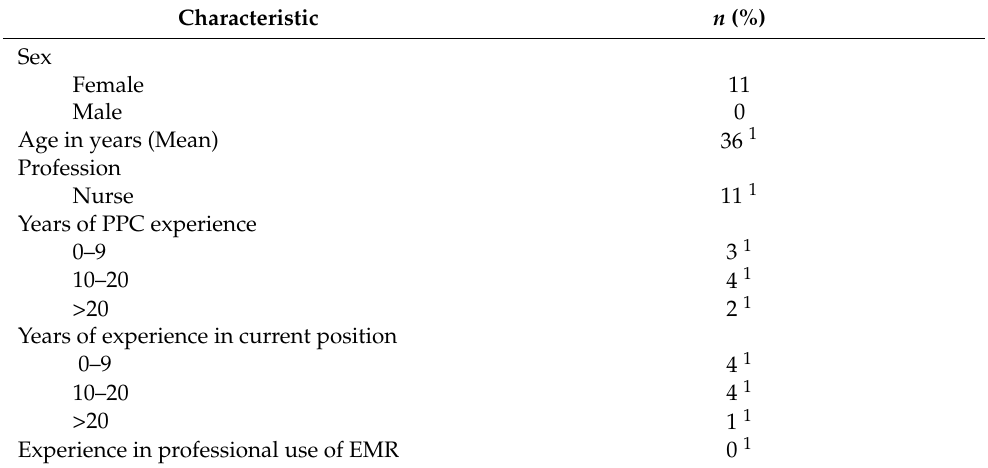
Table 2. Overview of participant